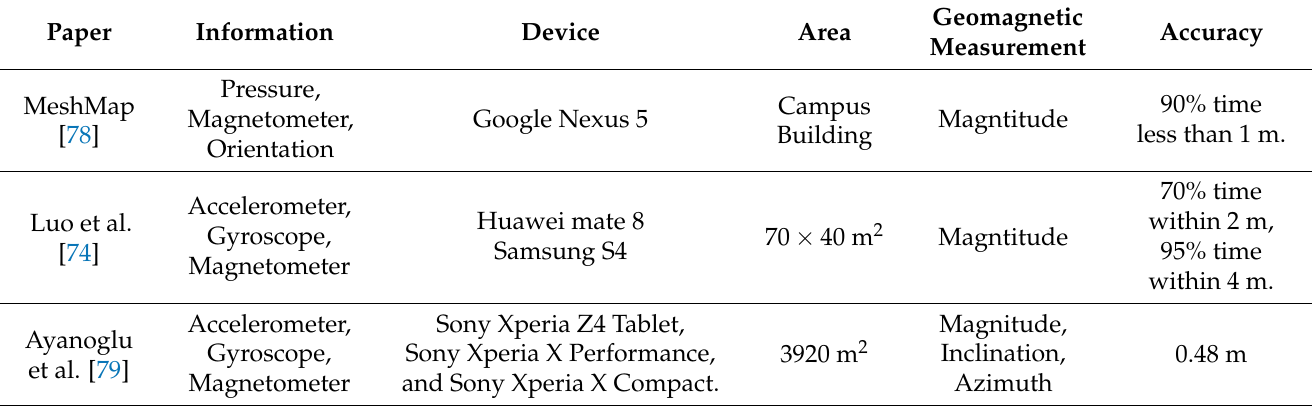
Table 4. Comparison of crowdsourcing